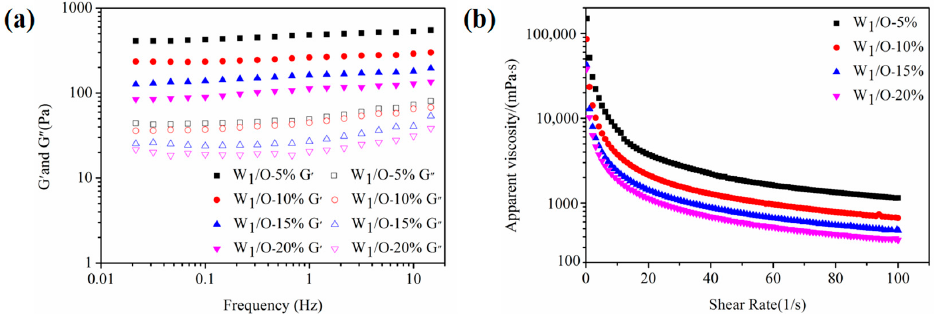
Figure 3. Rheological properties of W 1 /O/W 2 emulgels (W 2 , 1.0 wt% SSPs) with different additions of W 1 /O emulsion (5, 10, 15, and 20%). Frequency sweeps curves ( a ) of the multiple emulgels at fixed strain (1.0%, with the LVR) with frequency ranging from 0.01 to 15 Hz; Apparent viscosity ( b ) of the samples with shear rate from 0 to 100 1/s.